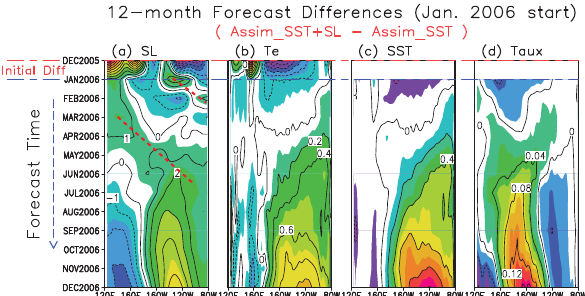
Figure 4. Initial and forecasted differences between the As- sim_SST + SL hindcast and Assim_SST hindcast for (a) SL, (b) T e , (c) SST, and (d) zonal τ x , illustrating the effects of the initial subsurface states, SL and T e on predicting the 2006–2007 El Niño event. The dashed red line in (a) represents the propagation of the downwelling Kelvin wave. The contour interval is 1.0cm in (a) , 0.2 ◦ C in (b) and (c) , and 0.04dyncm − 2 in (d) . The initial differ- ences in December 2005 for the subsurface states (SL and T e ) are demonstrated in the two panels on the left.